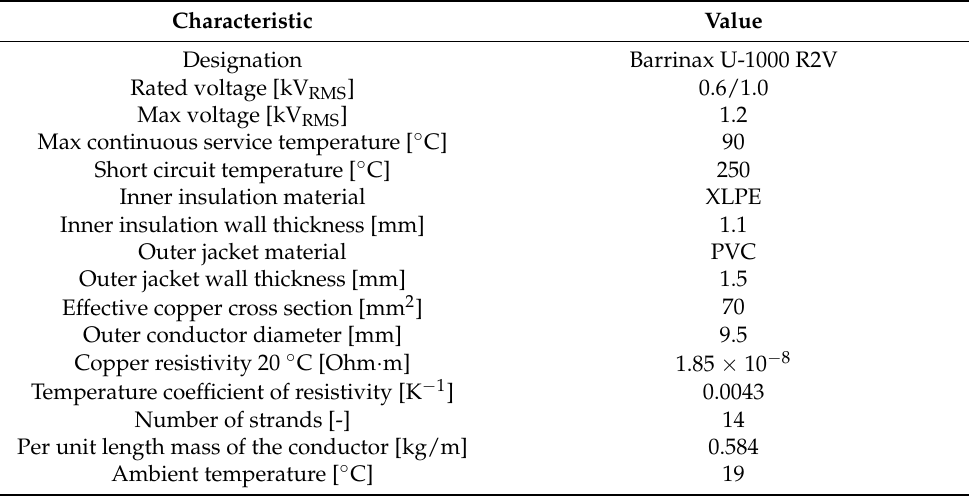
Table 1 details the main characteristics of the insulated cable used in the experiments. Table 1. Conductor dimensions and